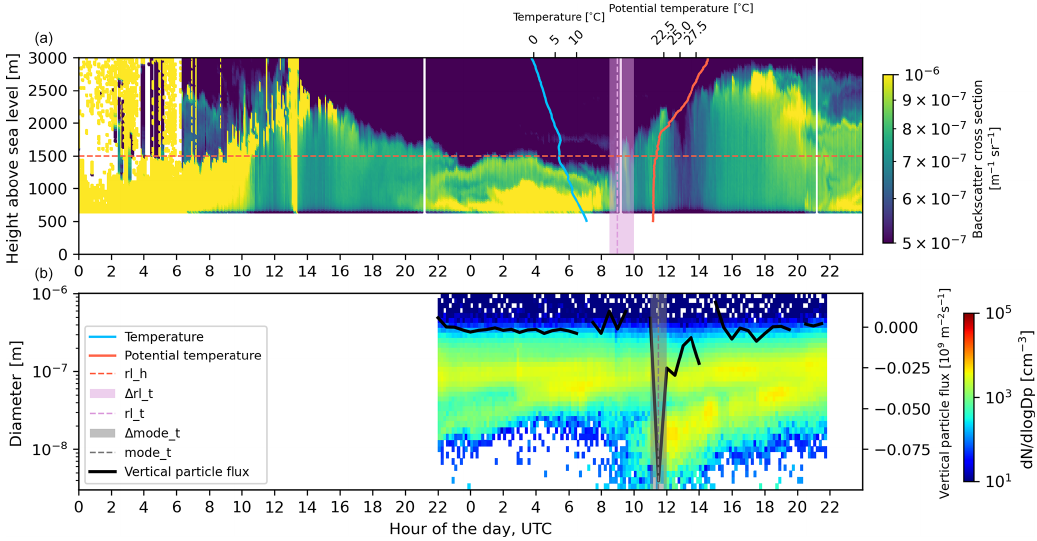
Figure 6. Panel (a) shows the backscatter cross section measured by the HSRL on 4–5 June 2014. The development of the ML is visible from the backscatter cross section signal. Temperature and potential temperature from soundings released in Hyytiälä at 05:20 and 11:20 on 5 June 2014, respectively, are superimposed. The horizontal line rl_h refers to the height of the inversion base in the sounding (height of the RL). The rl_t and (cid:49) rl_t refer to the time when the ML was estimated to reach the rl_h and the confidence interval for this time, respectively. Panel (b) shows the particle number size distribution measured at the SMEAR II station, the black line is the vertical particle flux. The mode_t and (cid:49) mode_t, respectively, refer to the time and the confidence interval when a nucleation particle mode that is associated with downward particle flux suddenly appears. Table 1. Summary of the BAECC dataset analysis. rl_h = residual layer height during night or early morning (ma.s.l.), rl_ht = time when the rl_h was observed (time when the sounding was released, hour of the day, UTC), mode_t = nucleation mode particle mode first appears (hour of the day, UTC), mode_t1/mode_t2 = nucleation mode particle mode appearance confidence interval (hour of the day, UTC), rl_t = new mixed layer reaches the top of the residual layer (hour of the day, UTC), rl_t1/rl_t2 = new mixed layer reaches the top of the residual layer confidence interval (hour of the day, UTC), bl_h = observed maximum height of the previous day’s boundary layer (ma.s.l.), dp = mean mode diameter for the newly appeared particle mode, when they first appear (nm), gr = growth rate calculated for the newly appeared particle